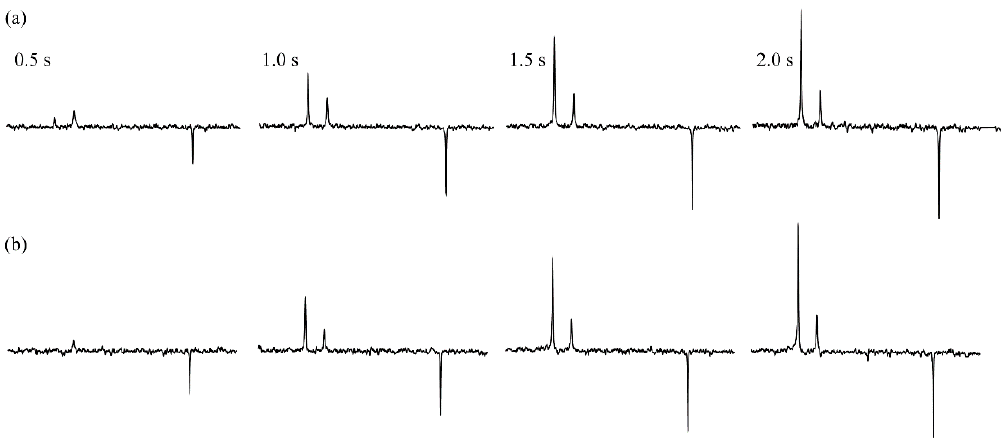
Figure 5. The 19 F-WaterLOGSY spectra acquired with various irradiation times in the range of 0.5–2.0 s, using ( a ) Gaussian- and ( b ) square-shaped pulses. The repetitive time n was set to adjust the total irradiation times, and the pulse widths were the same as those used in Figure 3.